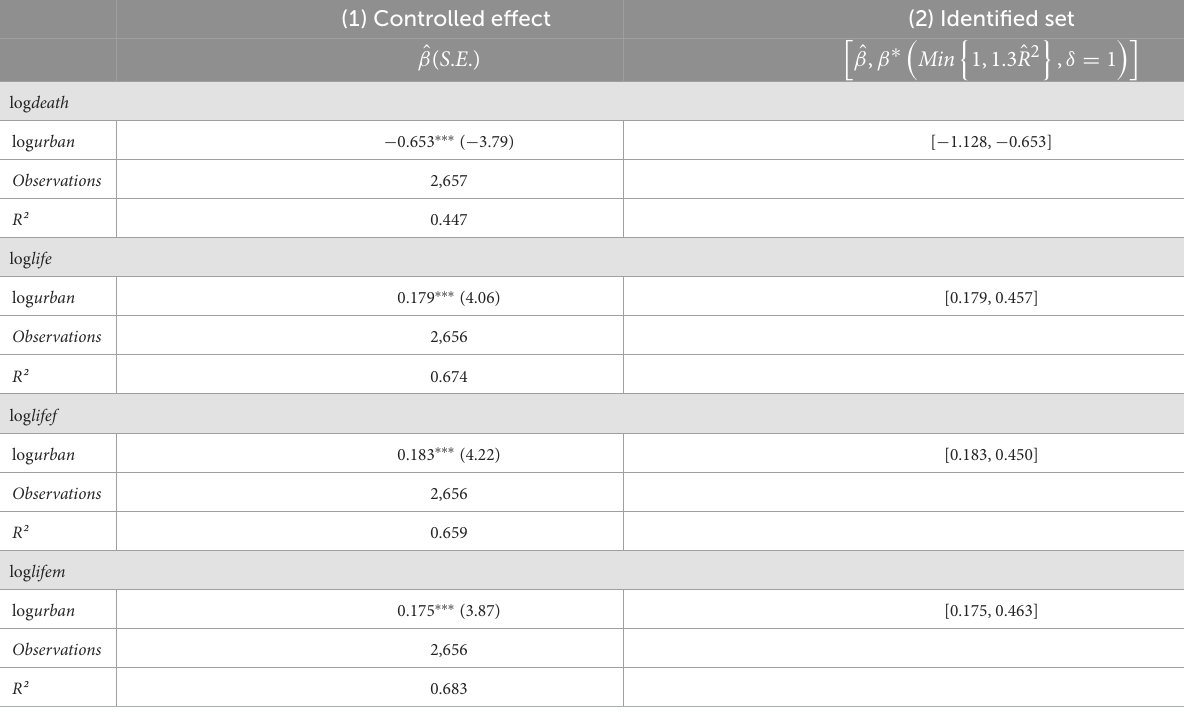
TABLE 5 Bound estimation results.